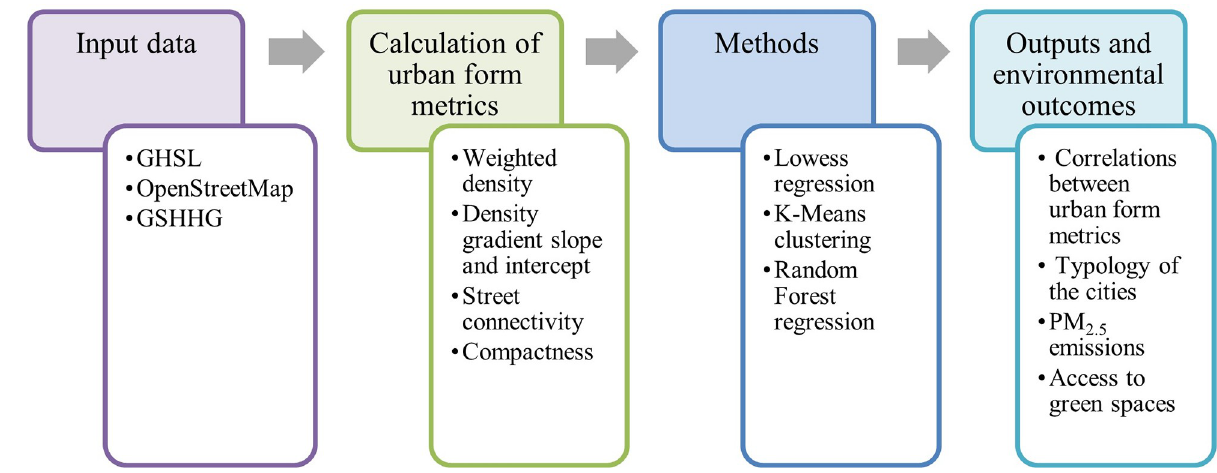
Fig 1. Flowchart of the input, process, and output of the study.